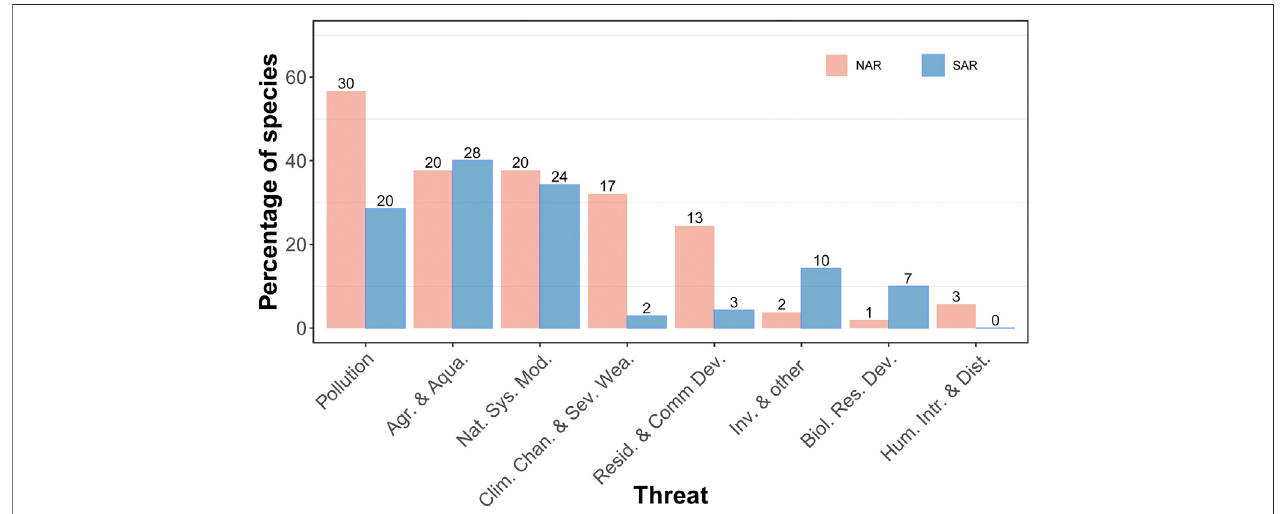
FIGURE 2 | Percentage of odonate species threatened by nine different threats in the Mediterranean climate of Northern and Southern African region. The percentage was calculated with respect to the total number of species recorded for each region. Numbers on the bars are the number of species.